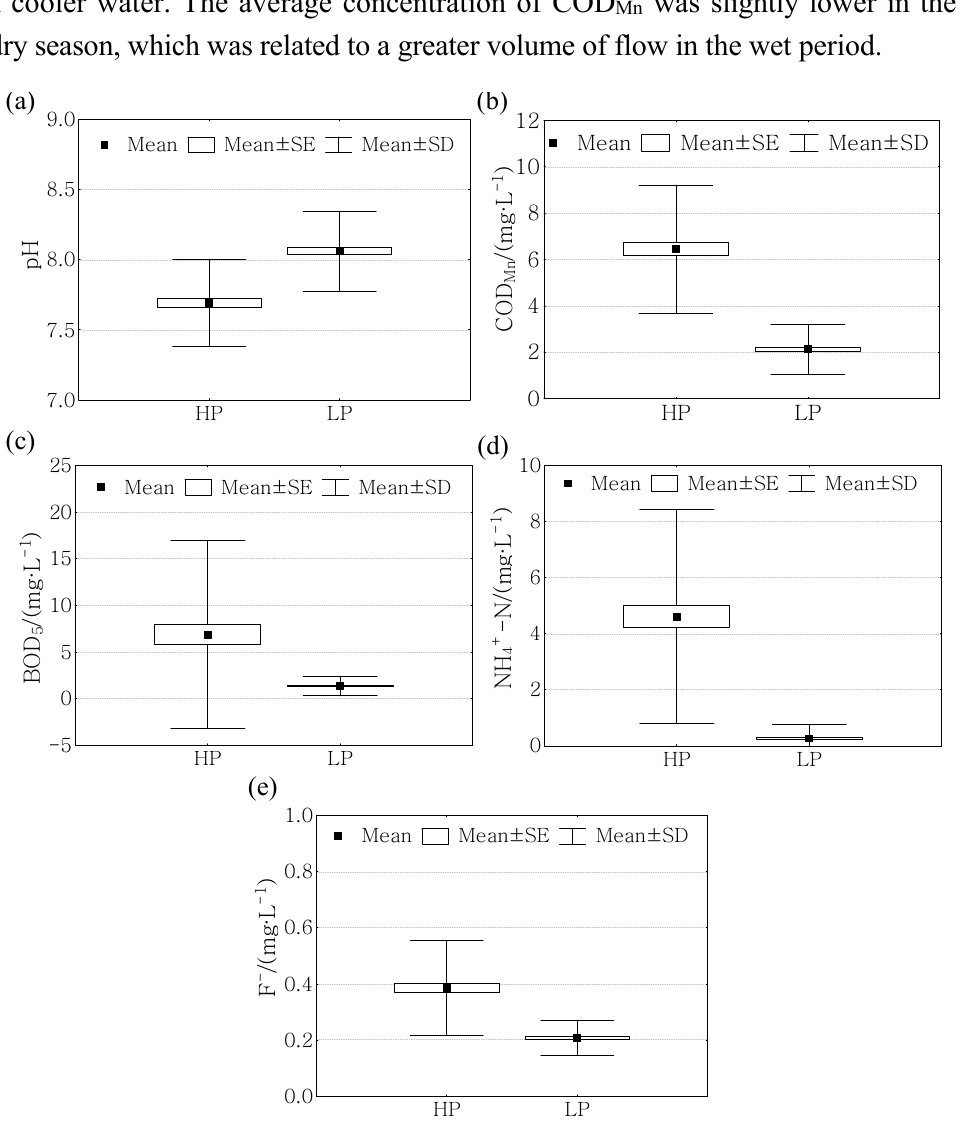
Figure 3. Spatial variations: ( a ) pH; ( b ) COD Mn ; ( c ) BOD 5 ; ( d ) NH 4+ -N; and ( e ) F − in Danjiangkou Reservoir